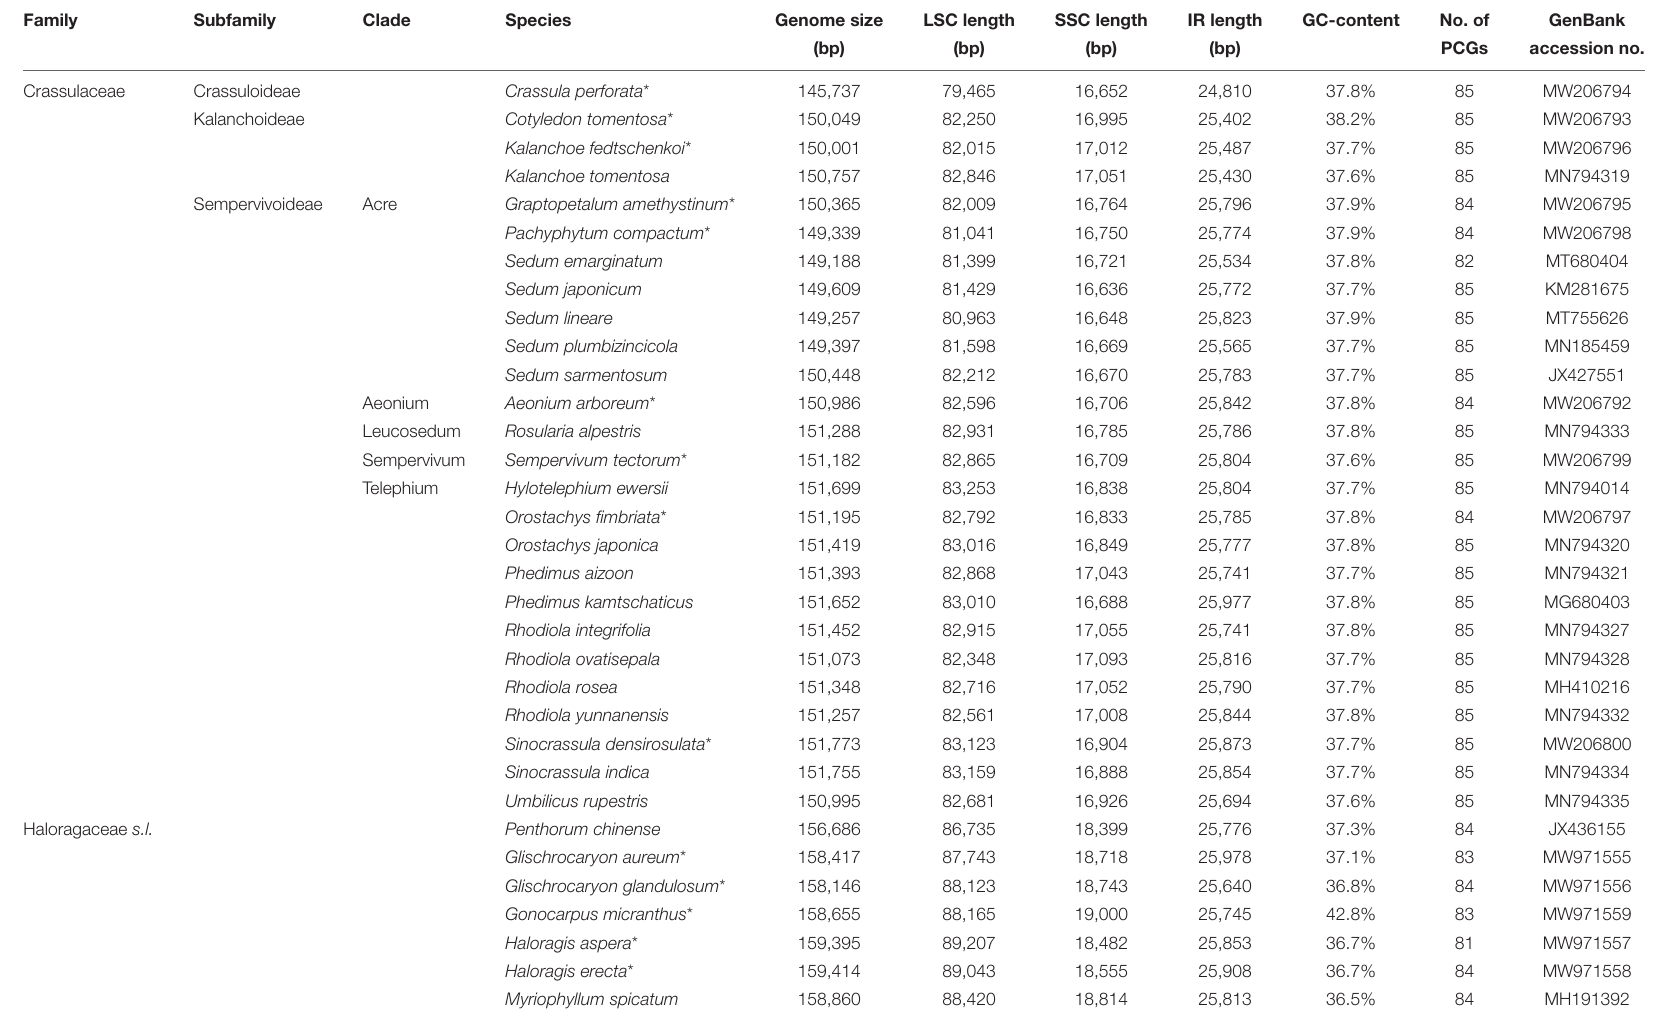
TABLE 1 | Structural information of the chloroplast genomes of Crassulaceae and outgroups.